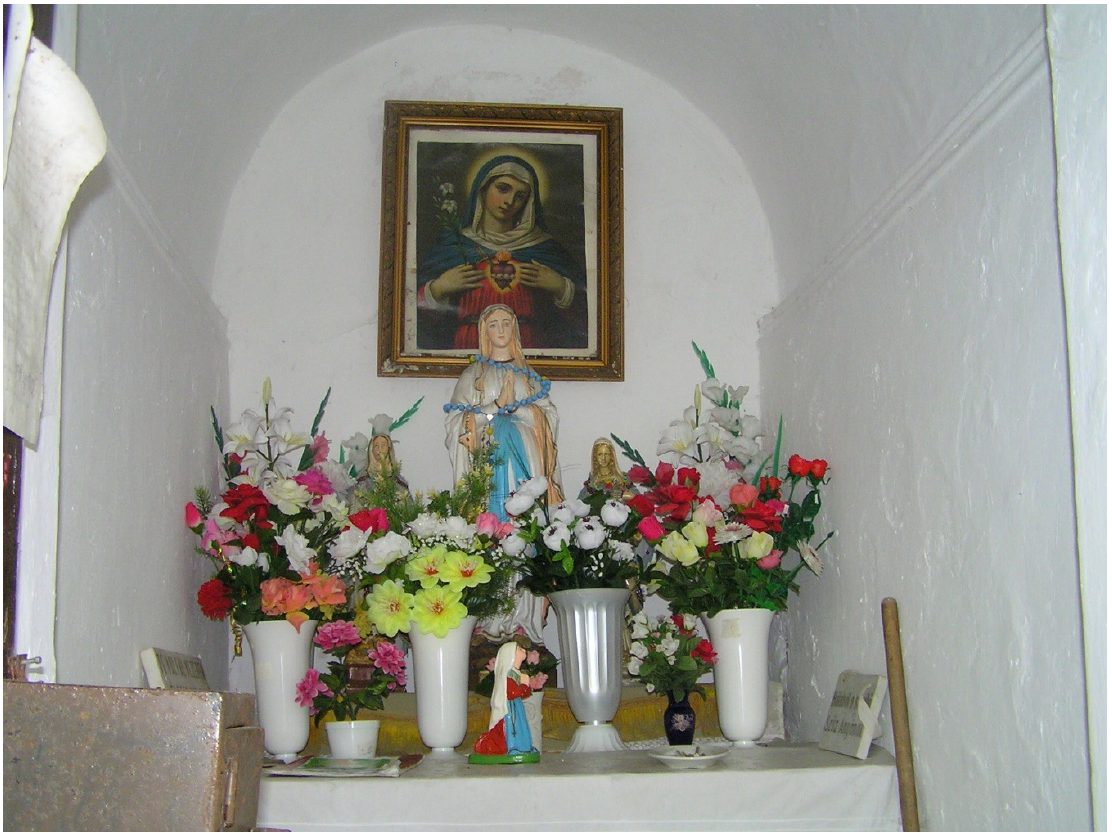
Figure 2. The Chapel in Egyházasbást-Vecsekl ő , Photo taken by (Krisztina Frauhammer 2012). This is a little-known shrine, located in a forest near the village. According to oral tradition, its origin is linked to a miraculous apparition of the Virgin Mary and to the nearby spring with a tiny chapel that was built here (big enough for only an altar and one chair); then in 2012 a new, larger chapel was built. From the 1970s, the woman who cared for the shrine at the time placed small notebooks here to redirect the practice of pilgrims to the site who used to write or scratch their requests and words of gratitude on the walls of the chapel. Since the church had not provided a “guardian” for the shrine, zealous local women kept it tidy. They have always ensured that new exercise books are placed when needed. During my research in 2012, I also observed that the full books were given a new life. They were placed beside prayer books, booklets for pilgrims and rosaries, so that visitors to the place for private devotions also leafed through them, drawing prayer texts from them. Mátraverebély-Szentkút, one of the most famous places of pilgrimage in Hungary, was my third research site. Here, the practice arose spontaneously, under the guidance of the clergy. From the 1990s, people began to leave prayer request slips on the altar of a former hermit’s cave near the pilgrimage church (Figure 3).